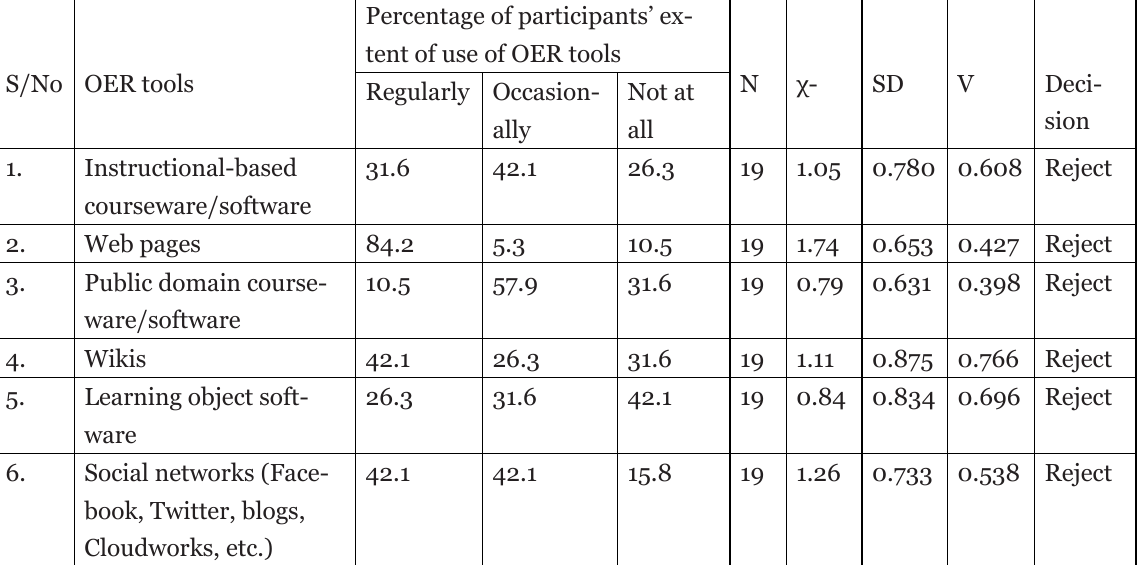
Participants’ Responses on Preference and Regularity of Use of OER Tools Percentage of participants’ S/No OER tools